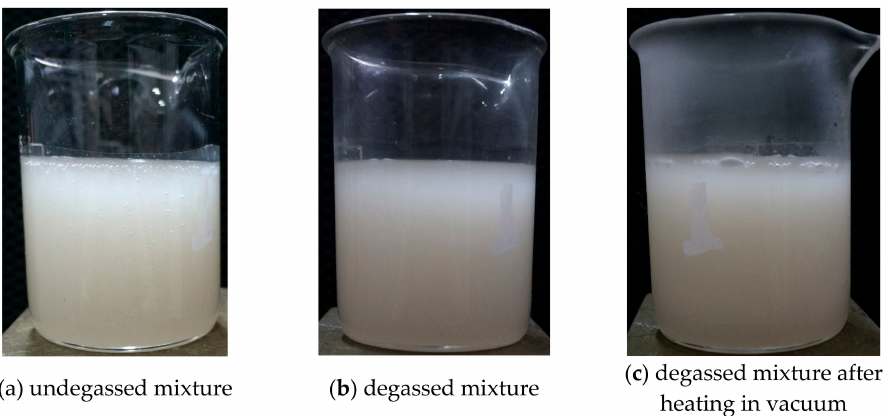
Figure 2. Photos of glycerol/zeolite mixture taken after different